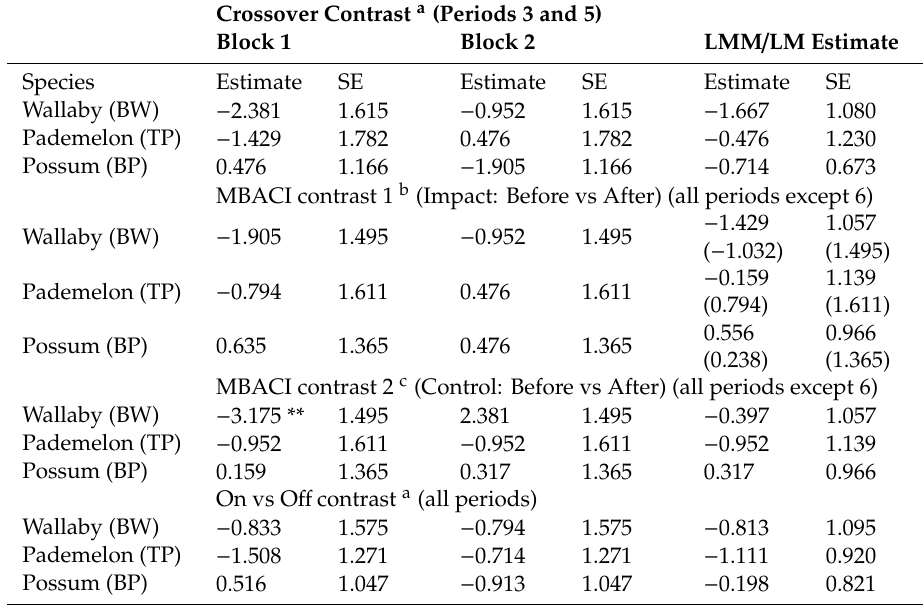
Table 3. Roadkill rates for three most prevalent roadkill species. Linear model contrast parameter estimates for standardised roadkill rates (number.month − 1 km − 1